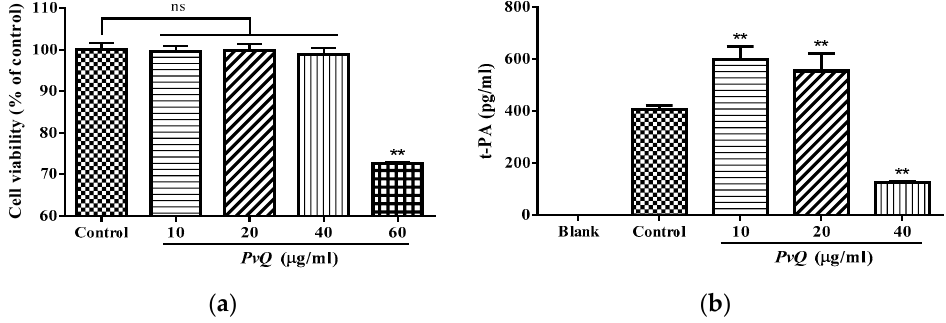
Figure 5. ( a ) CCK-8 assay to evaluate the cell viability of HUVECs treated by PvQ for 24 h and ( b ) the expression level of t-PA in the supernatant of HUVECs. Data are expressed as mean ± SD (n = 6). ns p > 0.05, ** p ≤ 0.01 compared to the control group.